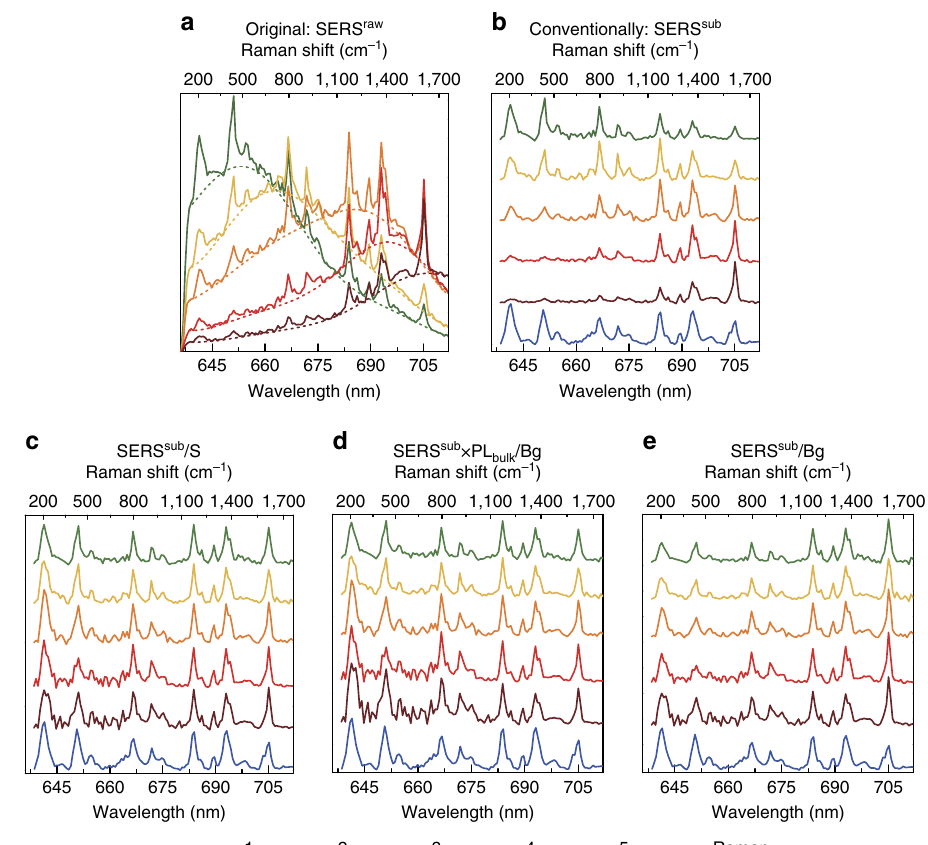
Figure 4 | Suppressing the PSSE to retrieve the intrinsic relative intensity of the Raman speaks. ( a ) SERS raw spectra from Fig. 3a–e, corresponding to five nanorods of different aspect ratio before background subtraction, plotted here in a single graph for simpler comparison. ( b ) SERS sub spectra obtained after subtracting the fitted SERS background Bg to the spectra in a . ( c – e ) Spectra obtained by normalizing each of the five SERS sub spectra in b . In c a normalization by the corresponding elastic scattering spectrum of each nanorod (dotted lines in Fig. 3f) is used to obtain SERS sub / S. ( d ) SERS sub (cid:3) PL bulk / Bg, obtained by dividing each background-subtracted SERS spectrum by the corresponding fitted SERS background and then multiplying each spectrum by the PL bulk signal in the bottom right panel in Fig. 2c. ( e ) SERS sub / Bg ratio, obtained after normalization by the SERS background. For comparison, the normal Raman spectrum of MGITC on a gold (111) single-crystal surface is shown at the bottom (blue line) of b – e . All the spectra in c – e , have been further normalized by the corresponding SERS sub peak at 683.8nm (corresponding to 1,173.3cm (cid:2) 1 in Raman